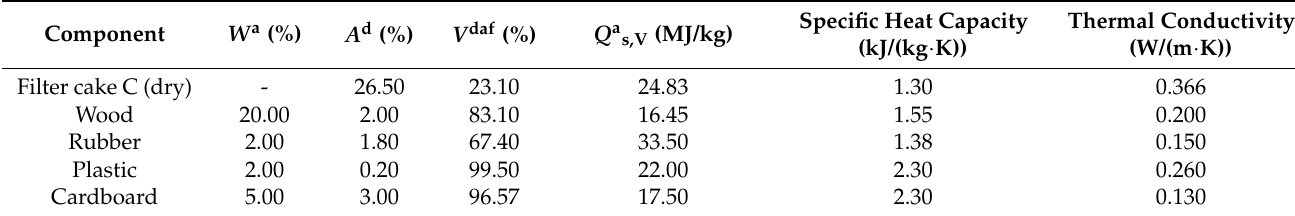
Table 1. Characteristics and properties of composite liquid fuel components [28].